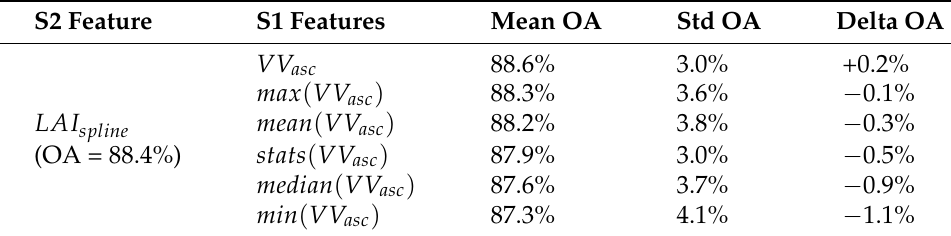
Table 4. Classification algorithm calibration results with the combined S1 and S2 features. For each feature time series, the mean overall accuracy (mean OA) and its standard deviation (std OA) over the 4 iterations of the cross-validation scheme are given. The change in OA compared to the use of S2 LAI spline (delta OA) is provided in the last